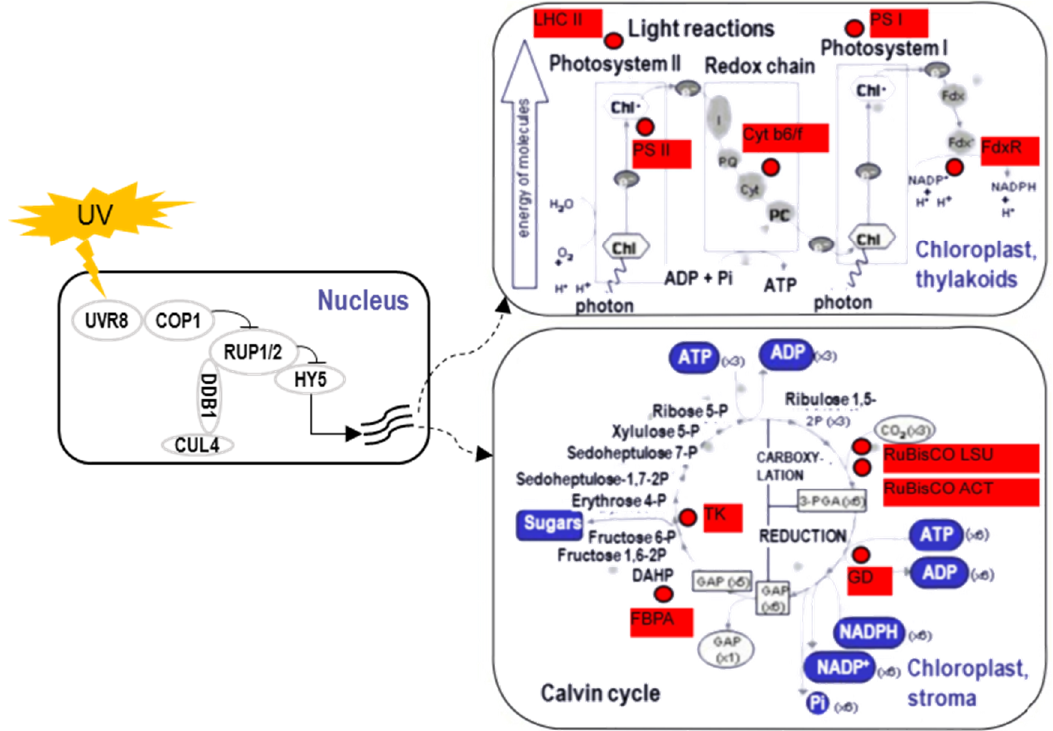
Figure 2. Signaling model in response to ultraviolet irradiation and altered proteins related to photosynthesis in plants. The altered proteins related to photosynthesis were mapped onto a pathway map from the MapMan software and marked with red color. Blue boxes indicate metabolites involved in photosynthesis. Curves in the left square indicate responsive transcripts. Abbreviations are as follows: LHC II, light harvesting complex II; PS II, photosystem II polypeptide; Cyt b6/f, cytochrome b6/f; PS I, photosystem I reaction center subunit; FdxR, ferredoxin NADP + oxidoreductase; TK, transketolase; FBPA, fructose bisphosphate aldolase; GD, glyceraldehyde-3-P dehydrogenase; RuBisCO, ribulose-1,5-bisphosphate car- boxylase/oxygenase; LSU, large subunit; ACT, activase; UVR8, UV RESISTANCE LOCUS 8; COP1, CONSTITUTIVELY PHOTOMORPHOGENIC 1; RUP, REPRESSOR OF UV-B PHOTOMORPHOGENESIS; DDB1, Damaged DNA binding protein 1; CUL4, Cullin 4; HY5, ELONGATED HYPOCOTYL 5.